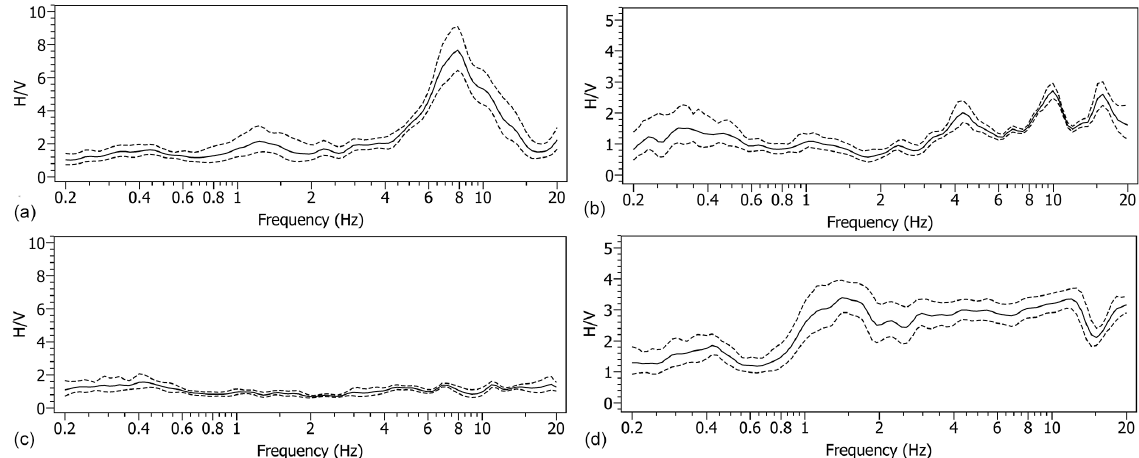
Figure 9. H / V topologies observed in the study area: (a) station with a clear peak, (b) station with multiple significant peaks, (c) station without peak and (d) H / V ratio showing constant amplification over a wide frequency range (step shape).